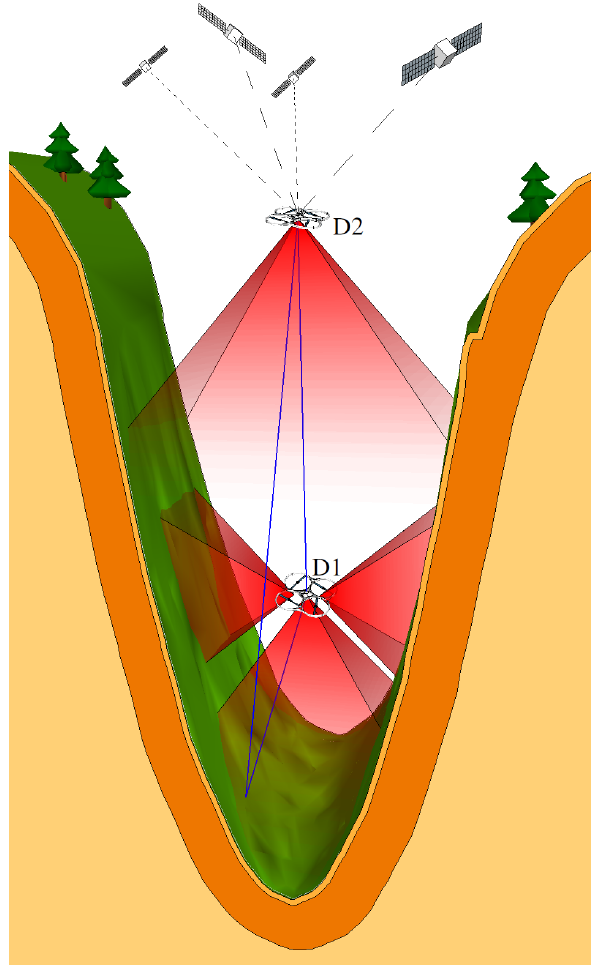
Figure 2: Schematic representation of the proposed method. Red shading represents field of view of the cameras embedded on D1 and D2 drone, blue lines represent image measurements, black dotted lines represent phase GNSS